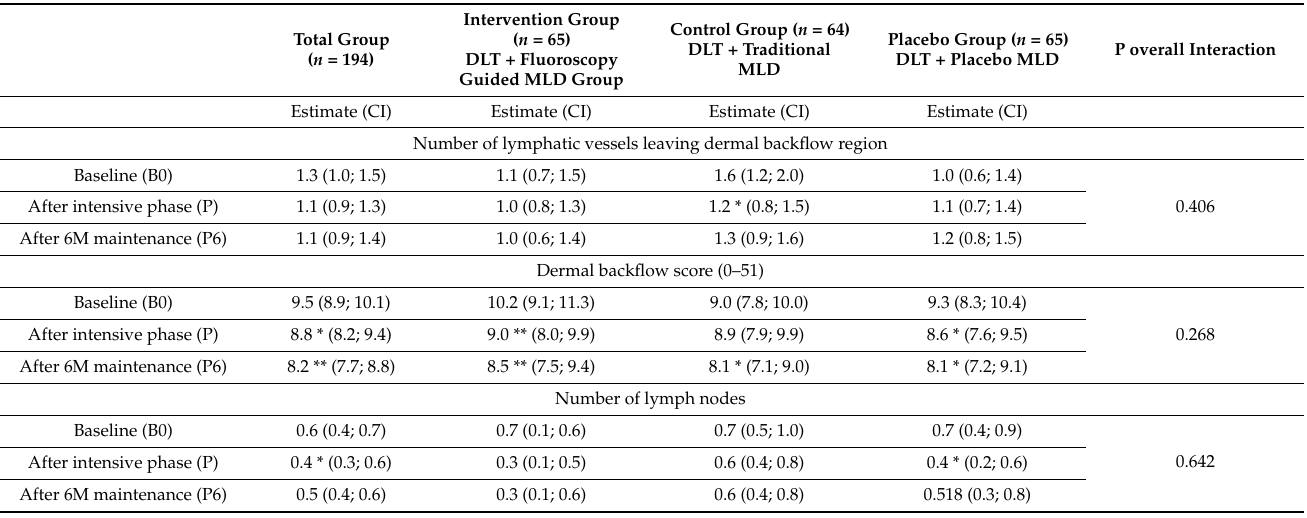
Table 4. Change of the lymphatic architecture from baseline to post-intensive phase and 6 months post-maintenance, with a comparison between the 3